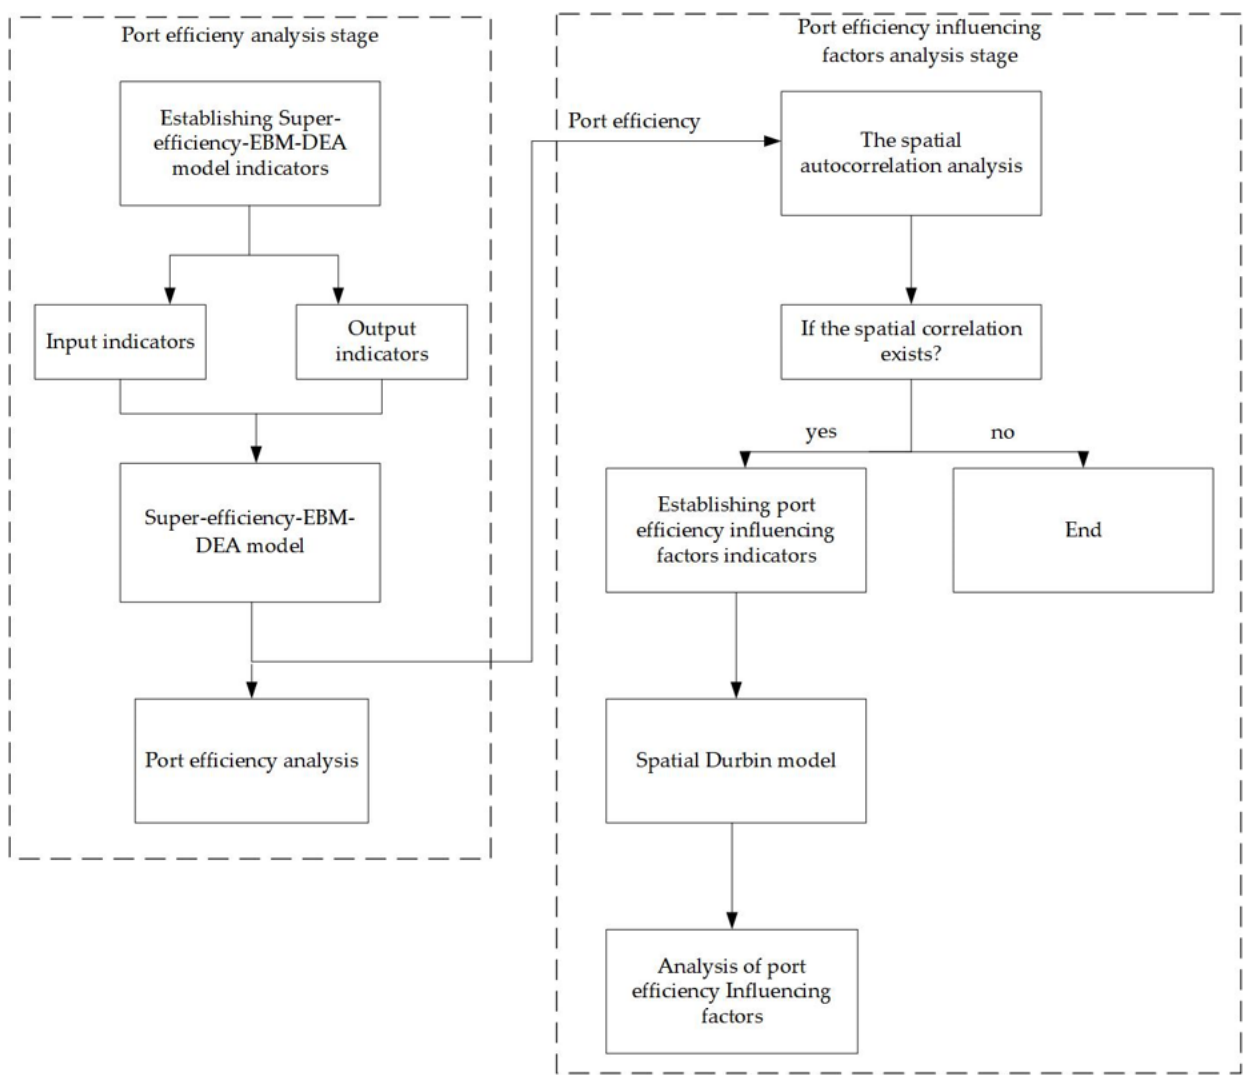
Figure 1. Flowchart of the methodology.